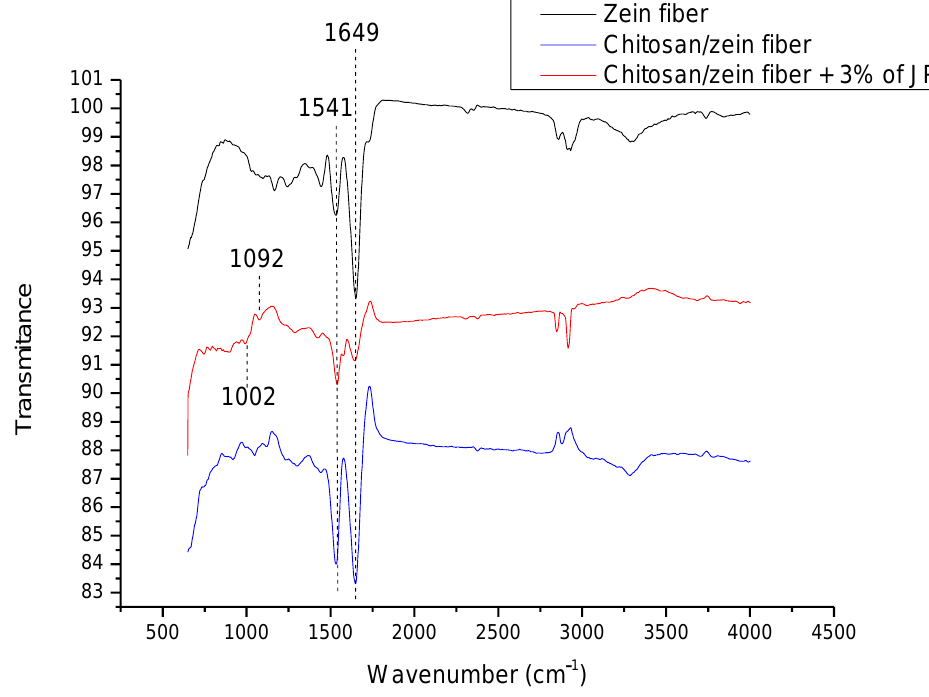
- Figure 6. FTIR spectra of zein fiber, chitosan/zein fiber, and chitosan/zein fiber + 3% of JPE.